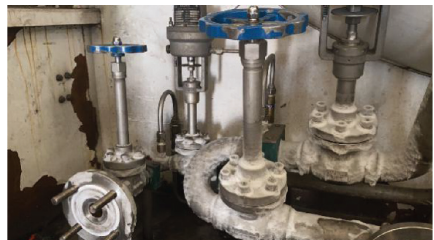
Figure 1: Operation diagram of cryogenic shut-off valve of LNG tanker.